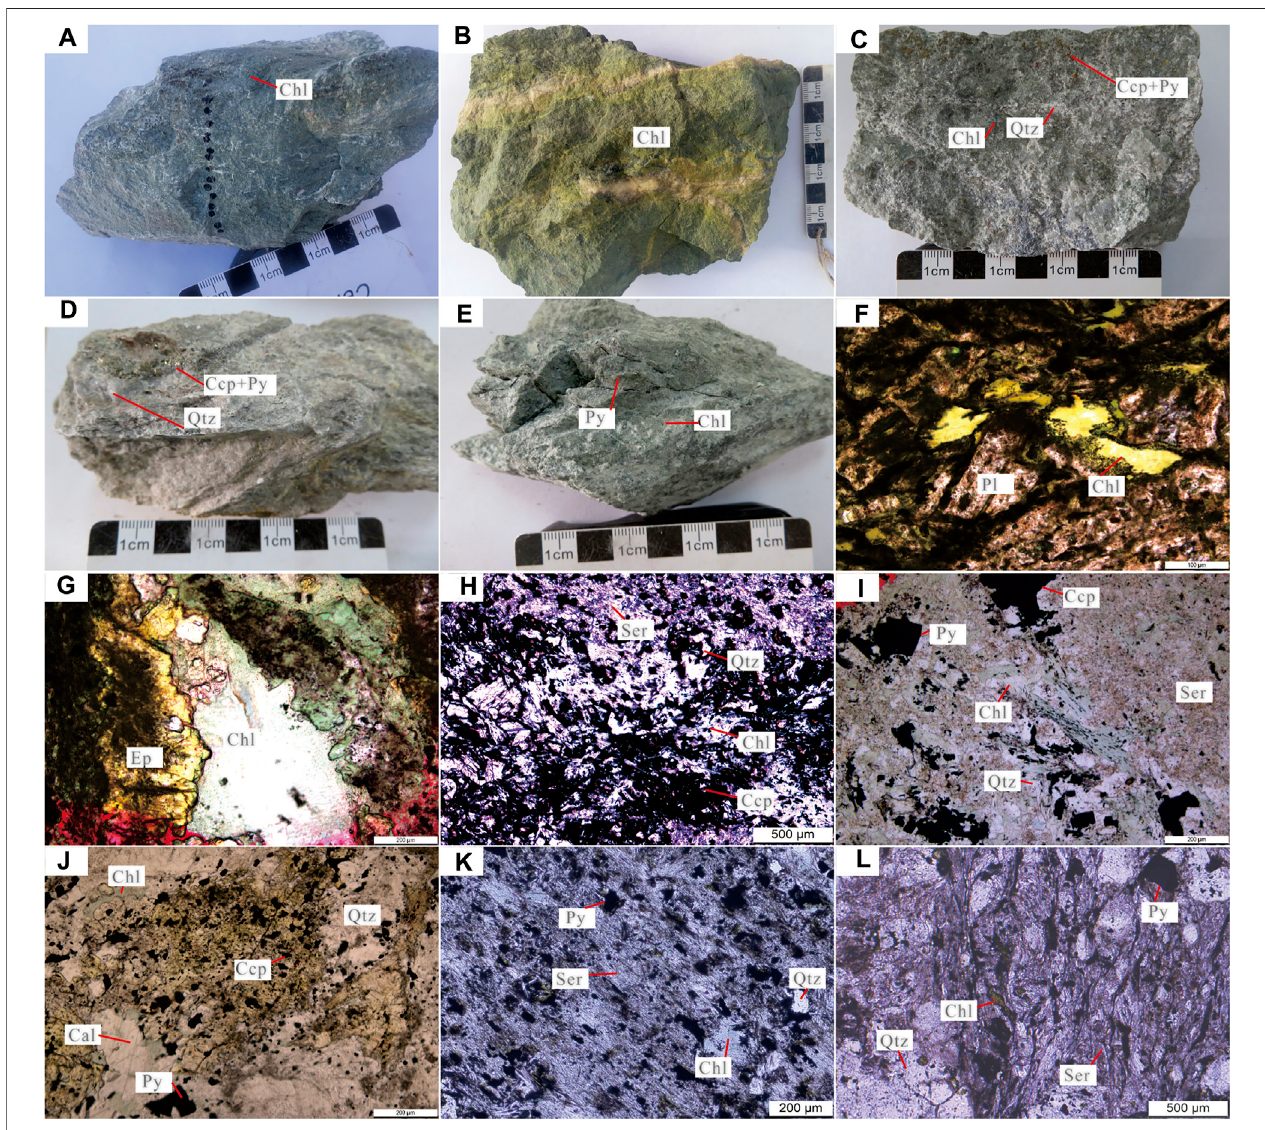
FIGURE 4 | Photomicrographs of the chlorite and specimens of typical ore samples from different mineralization stages of Tuwu porphyry Cu deposit in eastern Tianshan, Xinjiang, NW China. (A) Weakly propylitized basalt; (B) strongly propylitized basalt; (C) pyrite + chalcopyrite + chlorite + sericite in diorite porphyrite; and (D) pyrite + chalcopyrite + silici fi cation development in plagiogranite porphyry; (E) mylonitized diorite porphyrite; (f) weak chlorite development in basalt, Chl-I; (G) strong epidote and chlorite development in basalt, Chl-II 1 ; (H) pyritization, sericitization, silici fi cation, and chloritization of plagiogranite porphyry, Chl-II 2 ; (I) sericite, silici fi cation, and chlorite development in plagiogranite porphyry, Chl-II 2 ; (J) chlorite, epidote, pyrite, and calcite development in plagiogranite porphyry, Chl-II 3 ; (K) chlorite,chalcopyrite,andsericiteindioriteporphyry(chlorite,sericite,andpyritegrainshaveanorientedarrangement)Chl-III;and (L) chlorite,chalcopyrite,andsericitein diorite porphyry rock with an augen structure, Chl-III. Ccp, chalcopyrite; Py, pyrite; Pl, plagioclase; Chl, chlorite; Ep, epidote; Qtz, quartz; Cal, calcite; Ser, sericite.